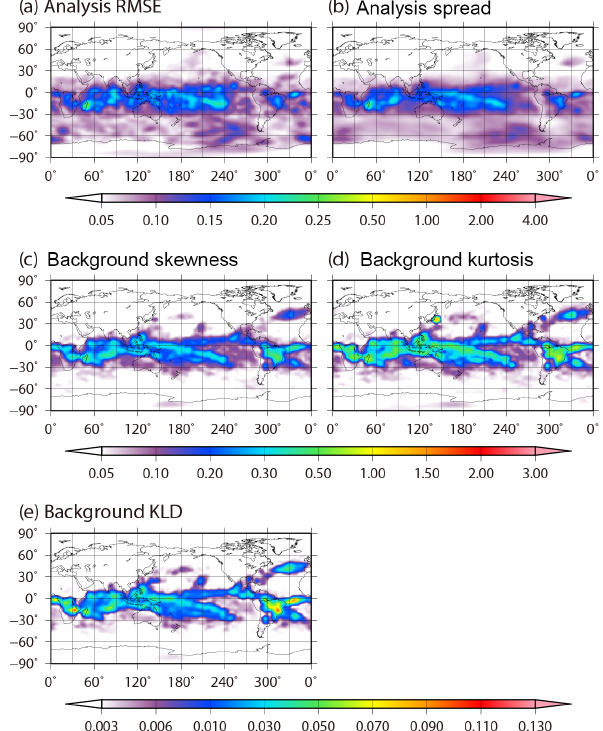
Figure 7. Spatial distributions of the time-mean (a) analysis RMSE, (b) analysis ensemble spread, (c) background absolute skewness, (d) background absolute kurtosis, and (e) background KL diver- gence for temperature at the fourth model level ( ∼ 500hPa) from 00:00UTC on 25 January to 18:00UTC on 1